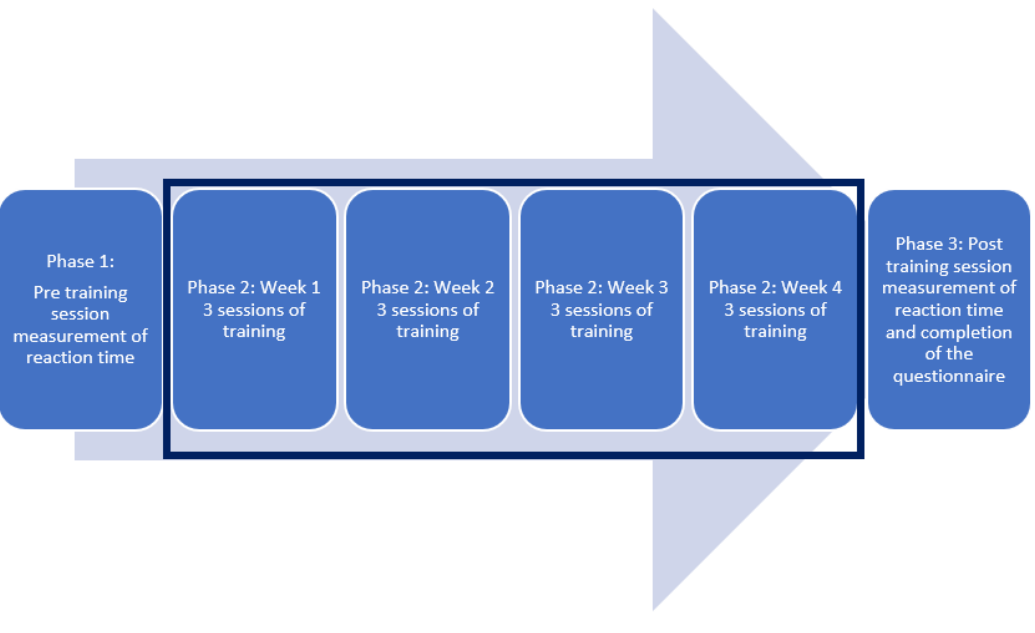
Figure 2. Experiment procedure.